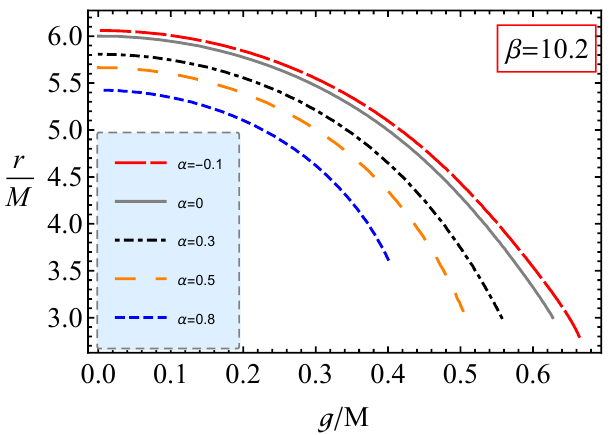
Figure 7. ISCO radius profiles of the magnetized test particle for the fixed value of the parameter β = 10.2 for different values of the NED magnetic charge and the GB coupling parameter α